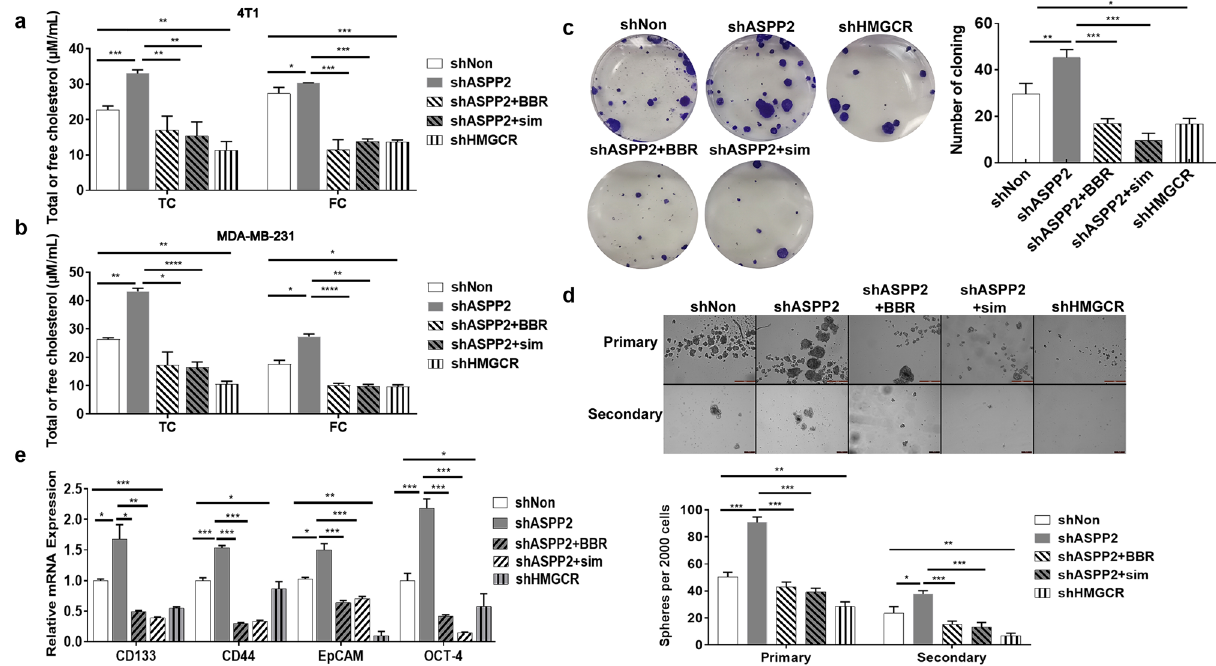
Figure 1. Cholesterol biosynthesis enhances colony and sphere formation in breast cancer cells. 4T1 ( a ) and MDA-MB-231 ( b ) cells were infected with lentivirus expressing shRNA targeting ASPP2 or HMGCR, and scramble shRNA (shNon) as control. 2 μM Simvastatin or 10 μM BBR were added to LV-shASPP2 infected cells. 24 h later, cells were collected and used for cholesterol content assays. ( c ) 2 × 10 3 4T1 cells per well were cultured in 6-well plates for 24 h, then cultured in medium containing 20% FBS for 12-15d. Colony number and representative images (left) were taken. ( d ) 1 × 10 5 4T1 cells were cultured onto ultralow attachment plates. Number of sphere formation in primary (6d) and secondary spheres (14d) were calculated. Representative images (left) was shown. Scale bar: 50 µm. ( e ) qRT-PCR assay for CD133, CD44, EpCAM and OCT-4 mRNA levels in treated 4T1 cells. * P < 0.05; ** P < 0.01; *** P <